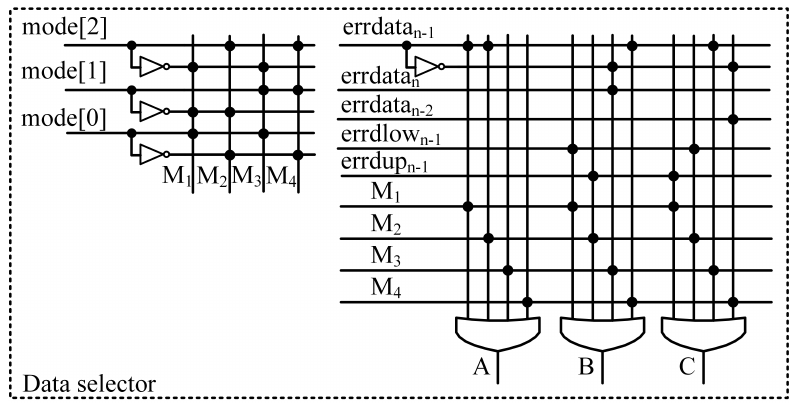
Figure 11. Logic gate circuit of Data Selector.